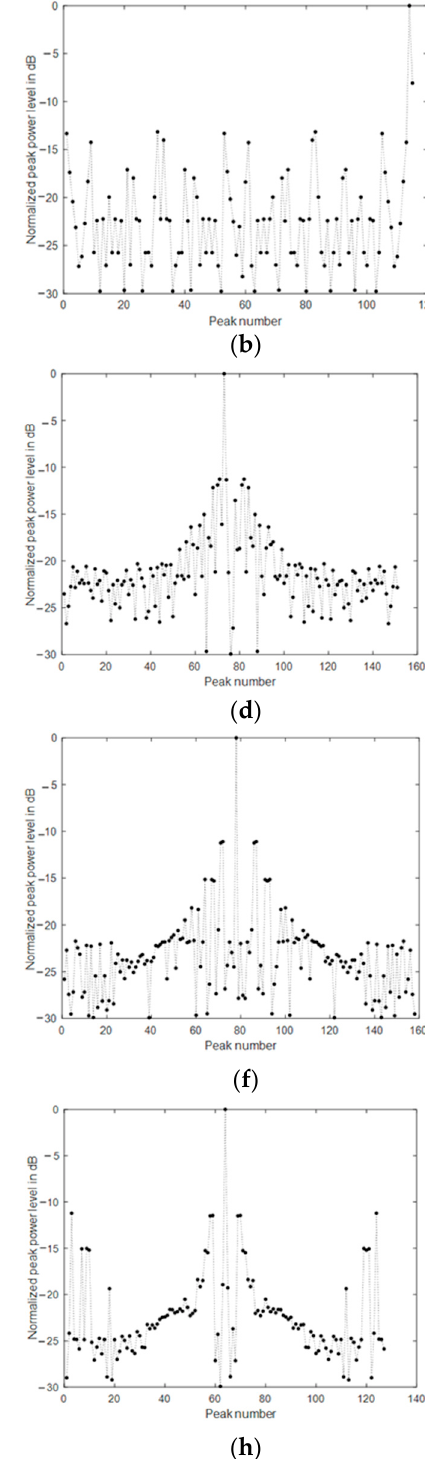
Figure 7. Normalized power pattern of uniformly fed CSC 4 ( a , c , e , g ) and the corresponding radiation peaks ( b , d , f , h ) at four different mainlobe directions (0°,180°), (30°,180°), (60°,180°), (90°,180°), respectively.